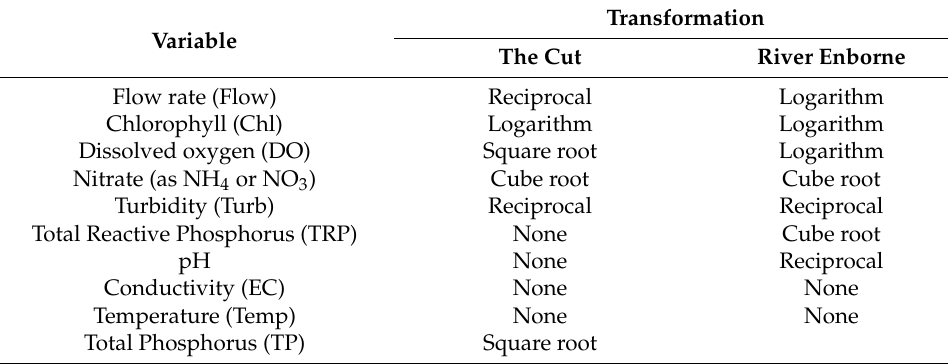
Table 2. Transformation of variables in each catchment. Transformation Variable The Cut River Enborne Flow rate (Flow) Reciprocal Logarithm Chlorophyll (Chl) Logarithm Logarithm Dissolved oxygen (DO) Square root Logarithm Nitrate (as NH 4 or NO 3 ) Cube root Cube root Turbidity (Turb) Reciprocal Reciprocal Total Reactive Phosphorus (TRP) None Cube root pH None Reciprocal Conductivity (EC) None None Temperature (Temp) None None Total Phosphorus (TP) Square